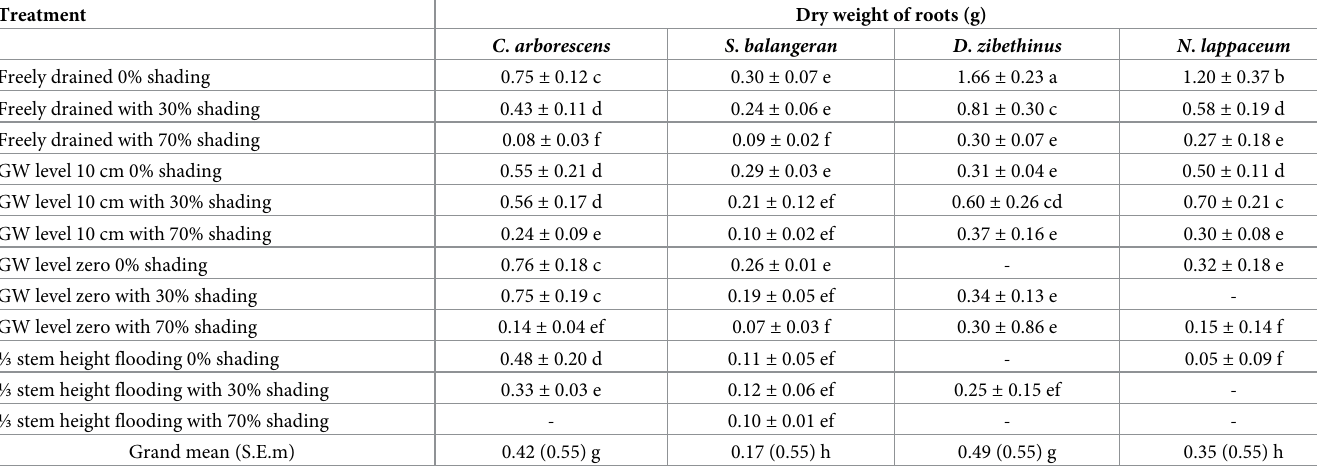
Table 6. Dry Weight (DW) of roots of four plant species under treatment combination of shading and inundation. Treatment